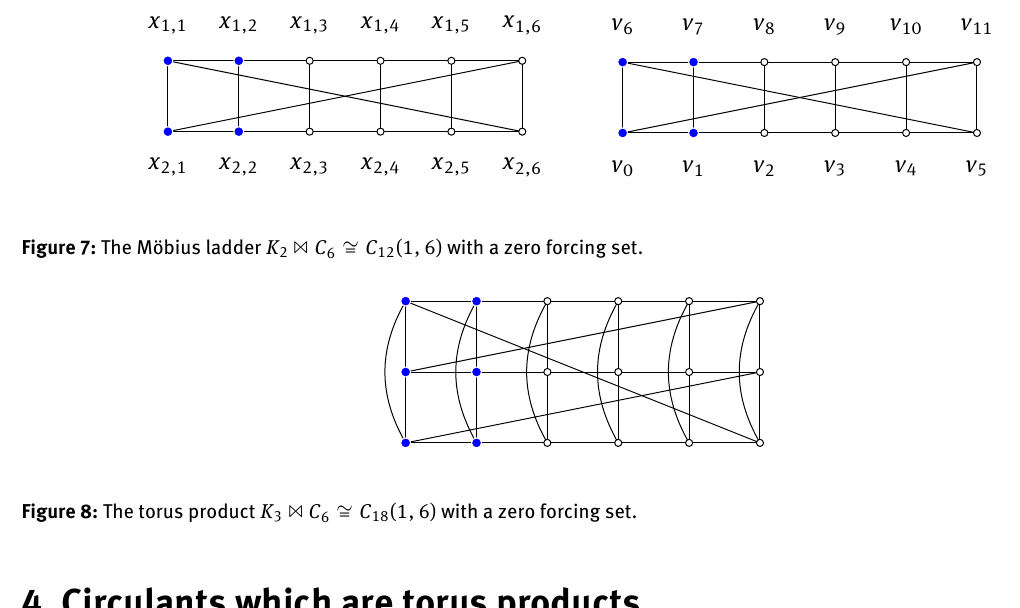
Figure 8: The torus product K 3